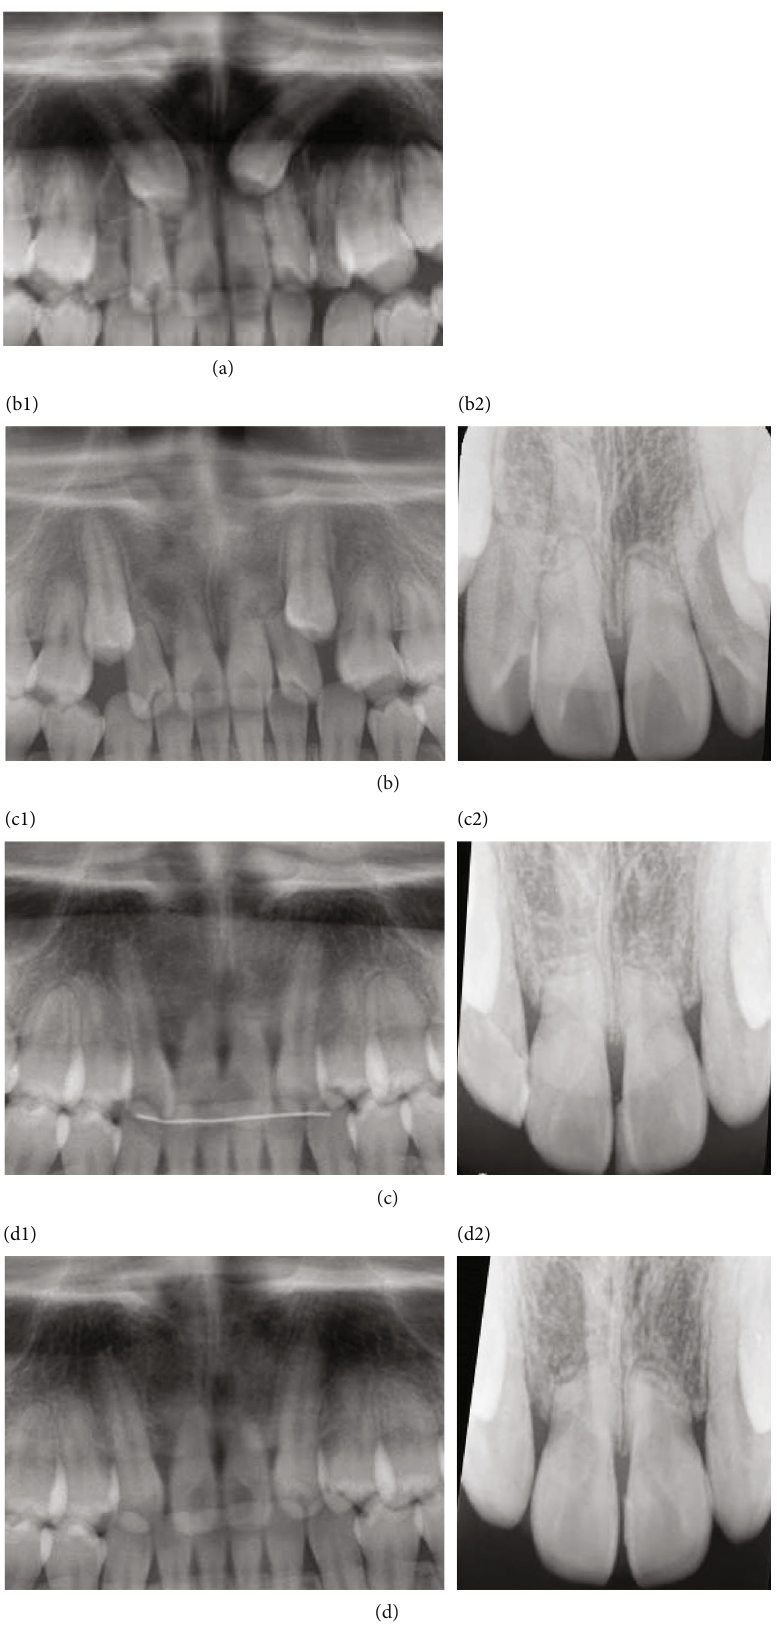
Figure 8: Panoramic radiograph revealing root resorption of maxillary incisors: (a) pretreatment, (b) post-canine traction, (c) posttreatment, and (d) two years